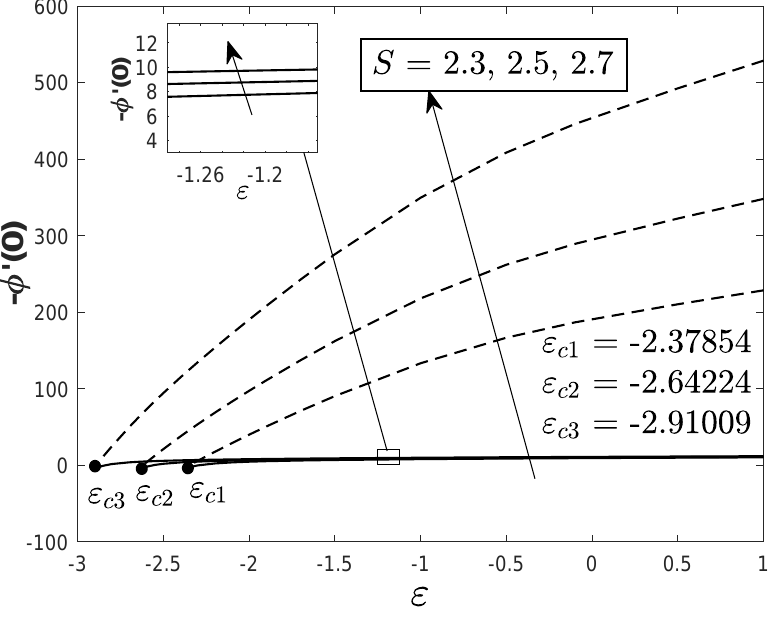
Figure 4. − φ (cid:48) ( 0 ) versus ε for various values of suction S .